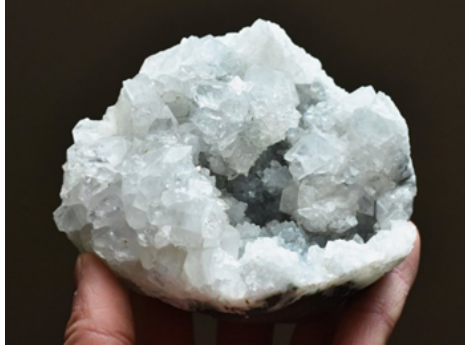
Figure 3. Photography of a